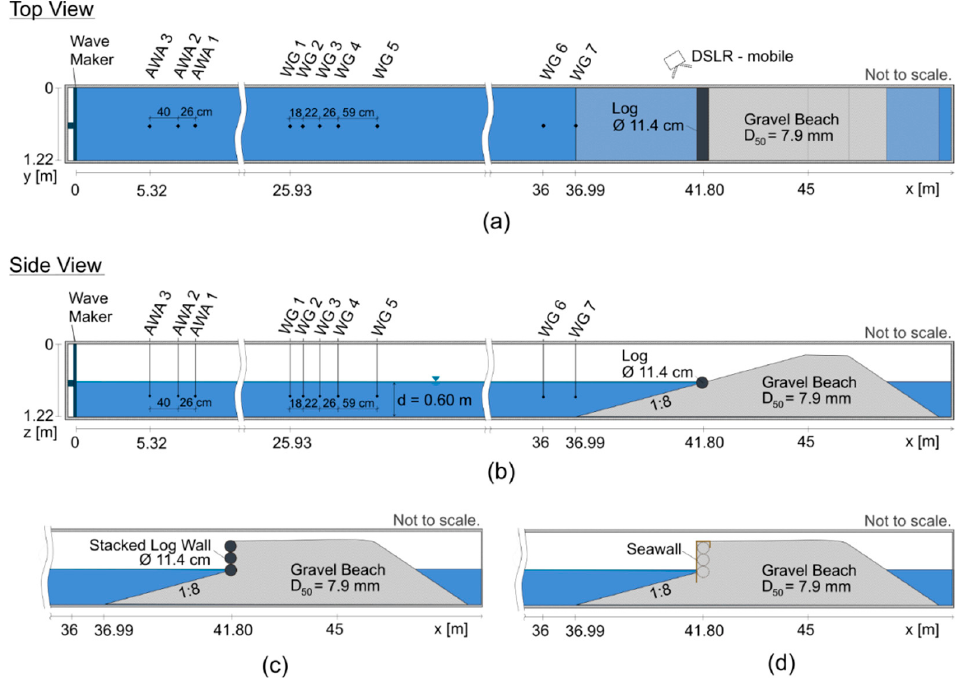
Figure 1. ( a ) Top view and ( b ) side view of base test setup ( Single ) in 2D wave flume including instrumentation; ( c ) setup for Stacked configuration, and ( d ) Seawall including backfill behind structure. The vertical seawall had the same freeboard as the three stacked logs (0.285 m) and